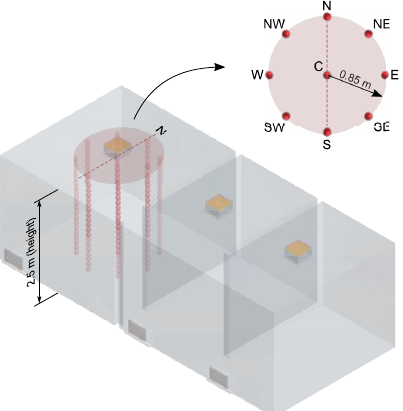
Figure 10. Data collection pillars were placed at the core of Room 1 for plotting vertical velocity profiles. Each pillar is formed by 20 stacked and uniformly spaced points over the compartment’s height, 2.5 m, and inside a neighborhood 0.85 m from the center, where pillar (C) is found. The other 8 pillars were placed in the cardinal directions along the azimuthal direction of the reference circle drawn at the room’s top